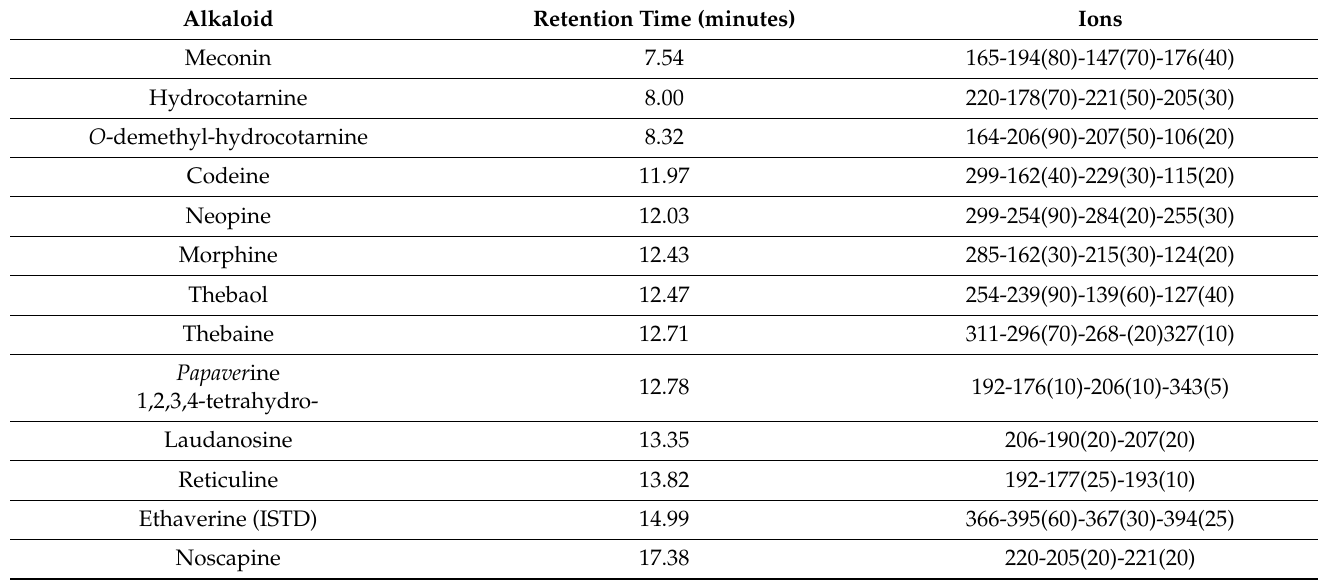
Table 1. Alkaloids found in the opium poppy